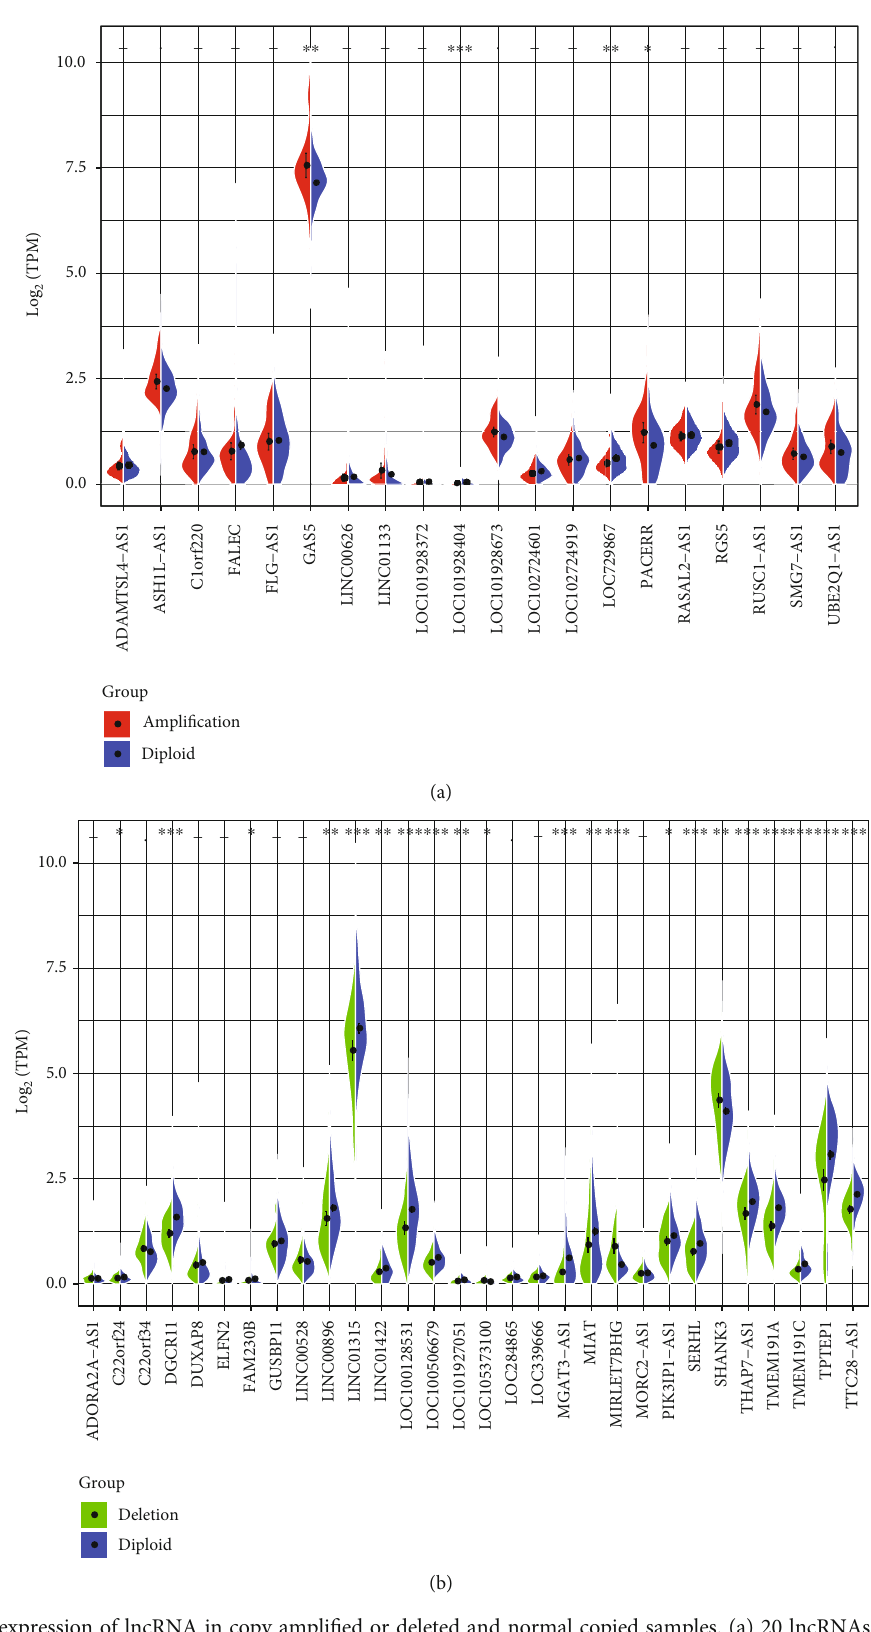
Figure 6: Di ff erent expression of lncRNA in copy ampli fi ed or deleted and normal copied samples. (a) 20 lncRNAs were copy-ampli fi ed, most of which were highly expressed in the copy-ampli fi ed samples. (b) 30 lncRNAs were copy-deleted, and the vast majority of which were signi fi cantly lowly expressed in the copy-deleted